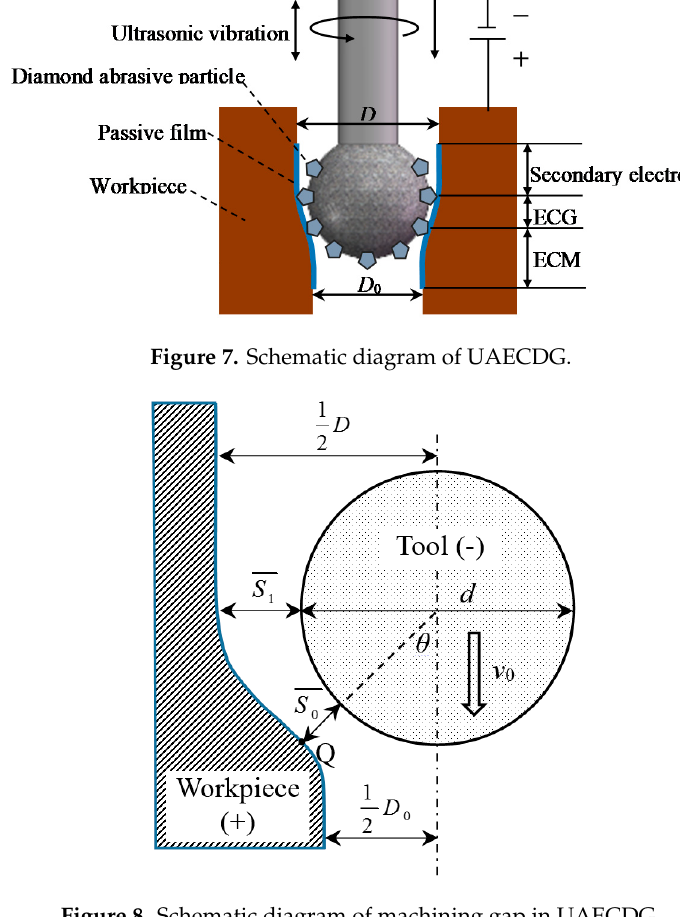
Figure 8. Schematic diagram of machining gap in UAECDG.